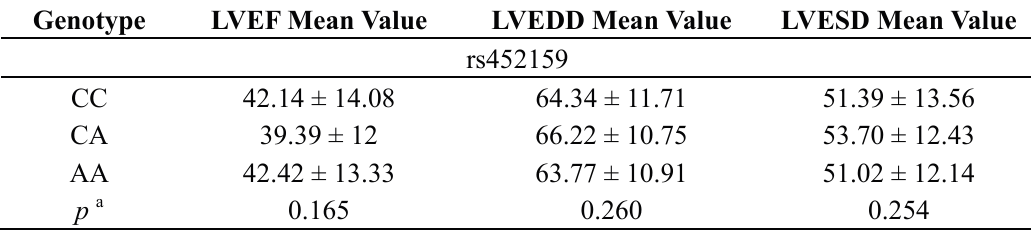
Table 5. Parameters related to the severity of CHF in different genotype